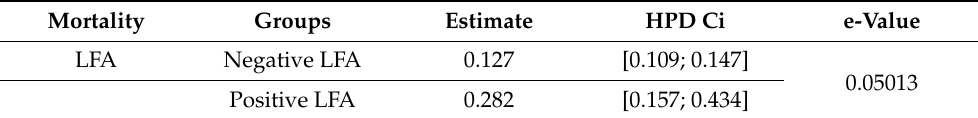
Table 6. Estimated prevalence of mortality on the posterior model and HPD credible intervals for positive and negative LFA groups and FBST evidence value for group comparison. Mortality Groups